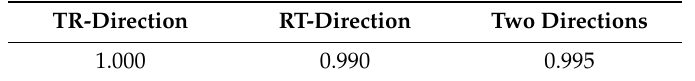
Table 4. Prediction accuracy in the conventional method used in